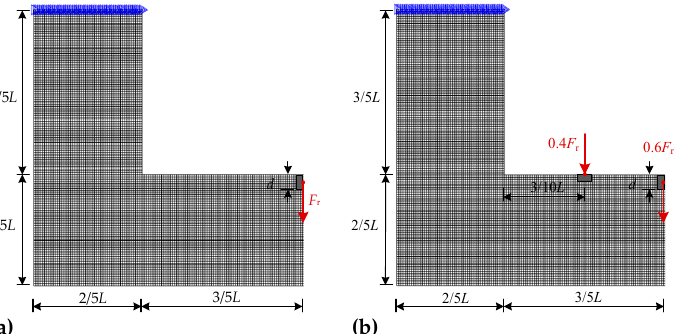
Figure 5. Design domain and boundary conditions for an L-bracket: ( a ) single load, ( b ) multiple loads.